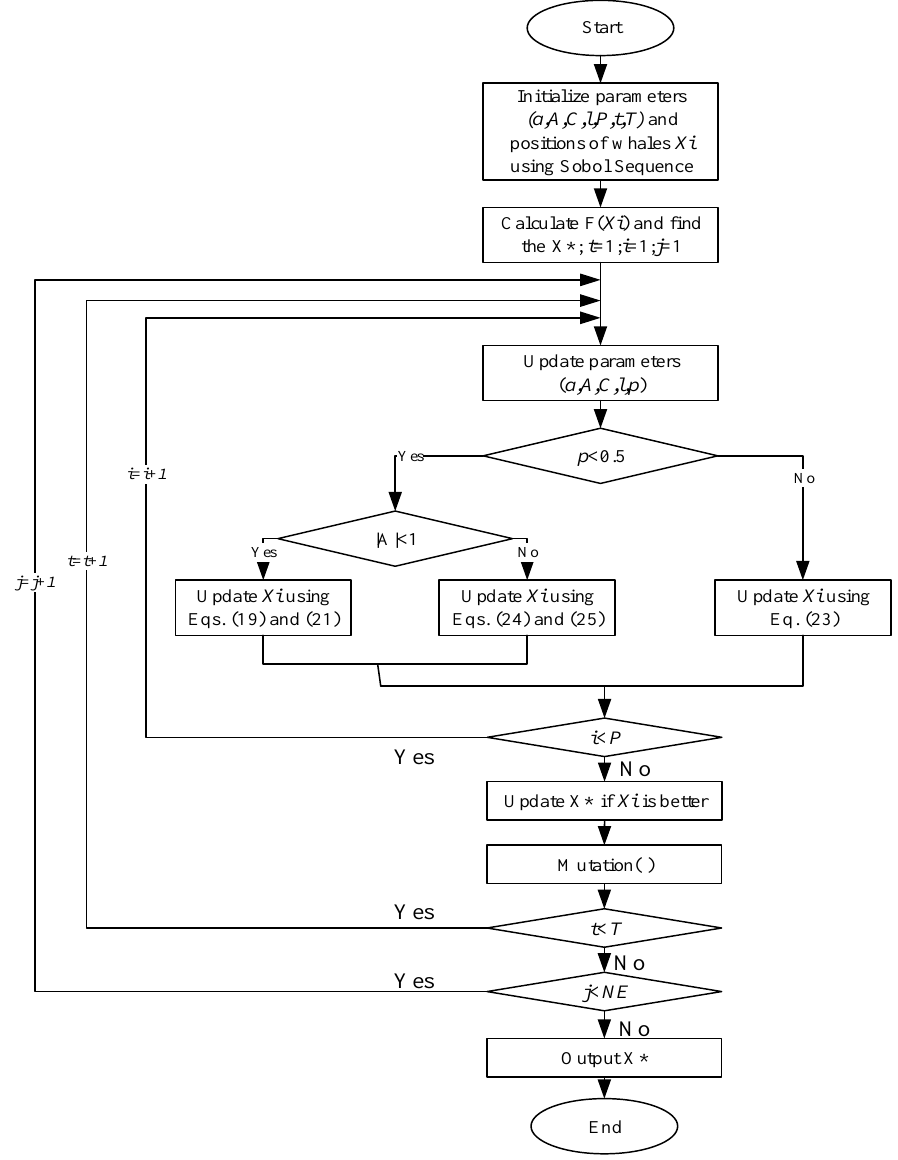
Figure 11. The workflow of Algorithm A3 of the IWOA.